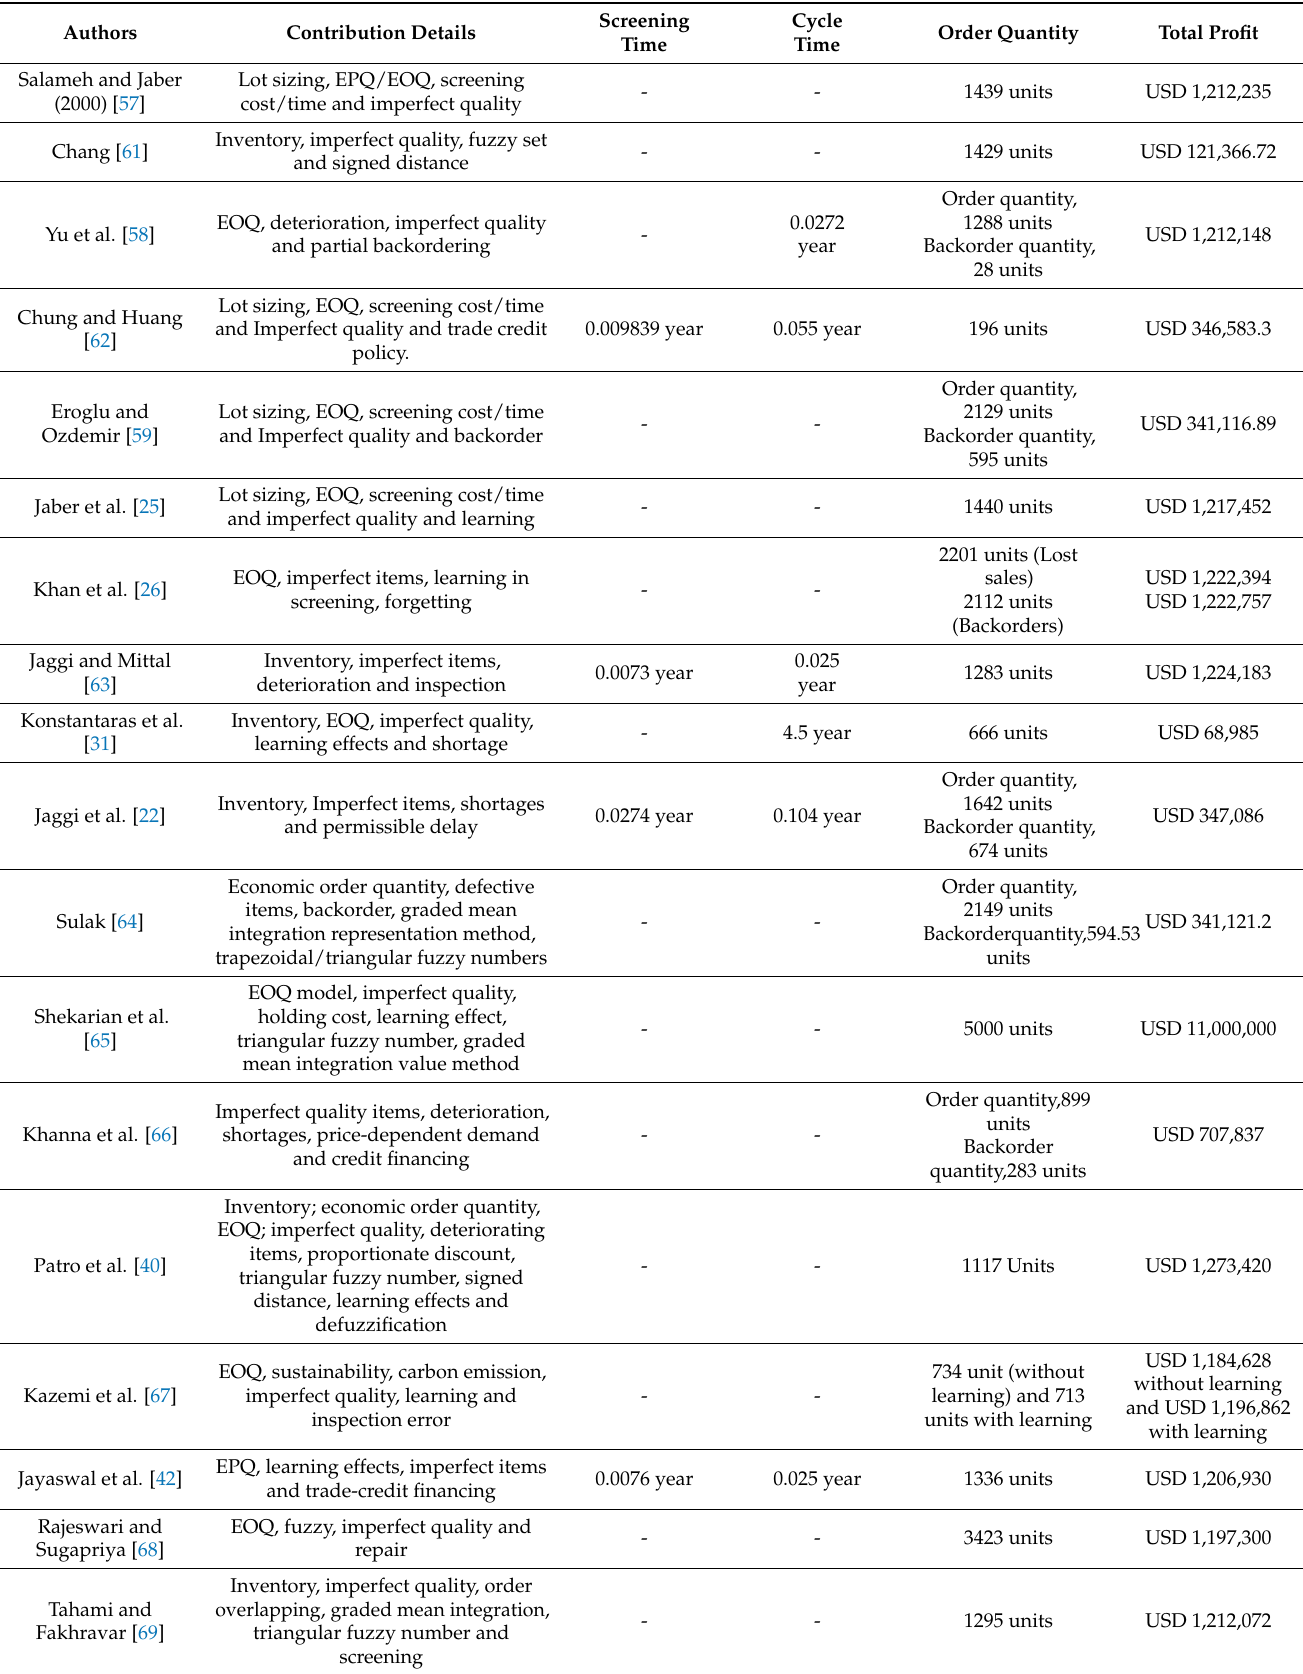
Table 7. Comparison of results with our proposed